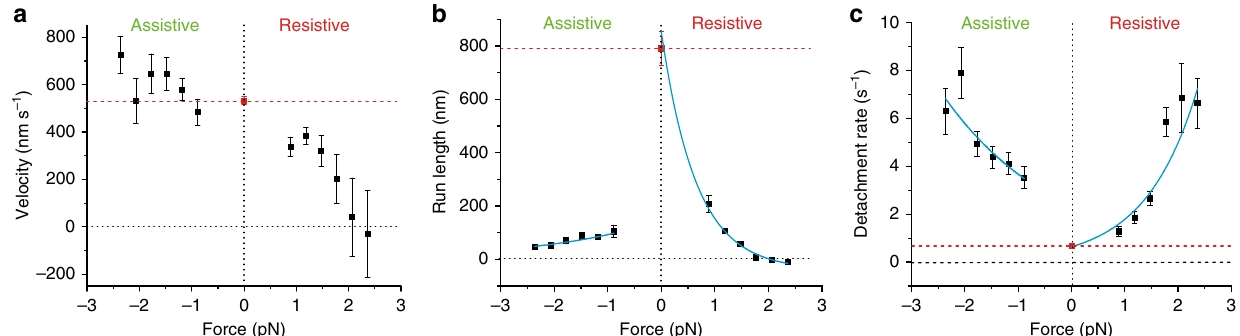
Fig. 4 Myosin-5B velocity and run length and detachment rate from actin are force sensitive. Force dependence of myosin-5B average velocity ( a ), run length ( b ), and detachment rate ( c ). Detachment rate is calculated as k = 1/< τ >, where < τ > is the average run duration. In all panels, assistive forces are negative, resistive forces are positive. Red squares are the unloaded velocity ( a ), run length ( b ), and detachment rate ( c ) measured with the single- (cid:1) (cid:3) (cid:2) F (cid:3) d ± L molecule motility assay ( n = 30). Cyan curves in b and c are fi ts of the exponential model equations L ¼ L ± k B (cid:3) T 0 exp where F is the absolute value of the force, k B the Boltzmann constant, T the temperature, and + or − superscripts indicate free parameters under positive or negative force, respectively. Fitted parameters are L 0 − = 148 ± 12 nm, L 0 + = 890 ± 120 nm, d L − = 1.9 ± 0.3 nm, d L + = 6.3 ± 0.6 nm and k 0 − = 2.3 ± 0.4 s − 1 , + = 0.64 ± 0.09 s − 1 , d − = 1.9 ± 0.5 nm, d + = 4.2 ± 0.4 nm. Fisher f -test applied to run length and detachment rate data under positive and negative k k k 0 force gave p value = 2E − 5 and 6E − 3, respectively, indicating signi fi cant difference of myosin-5B mechanosensitivity with force direction. [ATP] = 100 µ M. n = 756. Error bars ( a , b ), s.e.m. ( c ), s.e.m. obtained from error propagation σ k = σ τ < τ > − 2 . Box plots of run length and detachment rate box plot